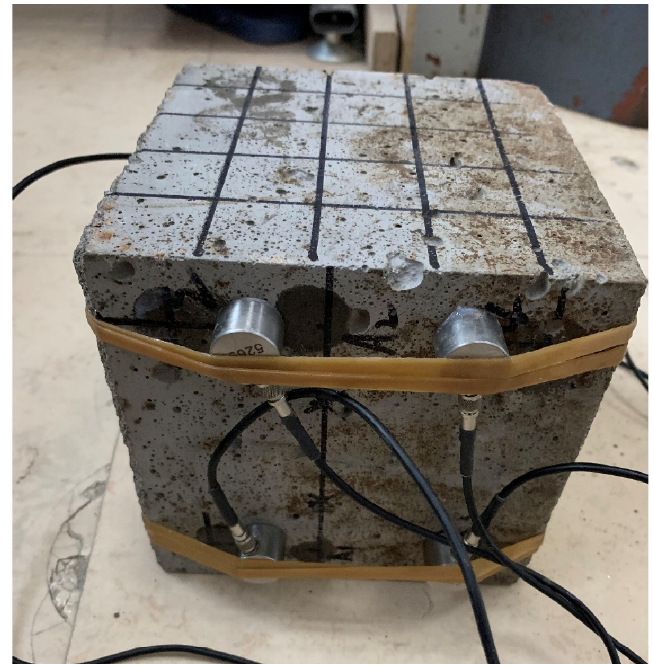
Figure 6. Pressure testing machine. Materials 2022 , 15 , x FOR PEER REVIEW